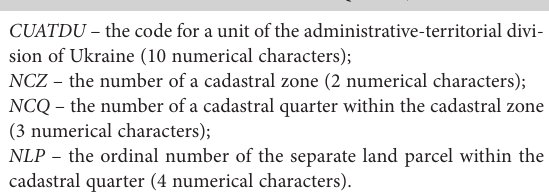
Figure 5. The structure of the “old” cadastral number of the land parcel (PKMU,